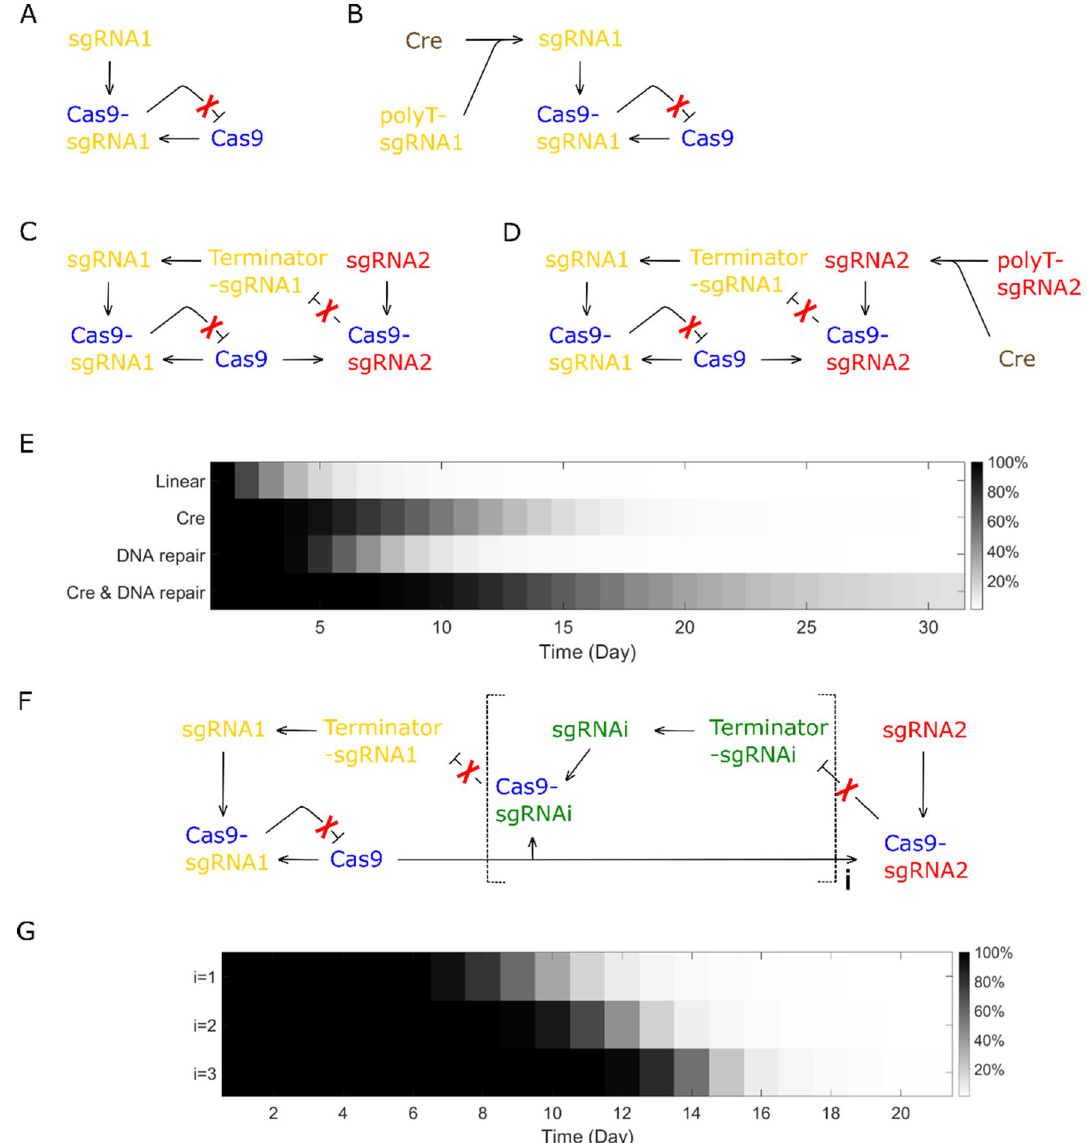
Figure 7. Safety switches utilizing intrinsic time delay. ( A ) Linear Cas9 elimination. ( B ) Time-delayed Cas9 elimination by Cre recombination. ( C ) Time-delayed Cas9 elimination by DNA repair. ( D ) Time-delayed Cas9 elimination by Cre recombination and DNA repair. ( E ) Dynamic process of Cas9 elimination for different circuits. ( F ) Time-delayed Cas9 elimination by cascade connection of DNA repair. ( G ) Dynamic process of Cas9 elimination with different number (i) of